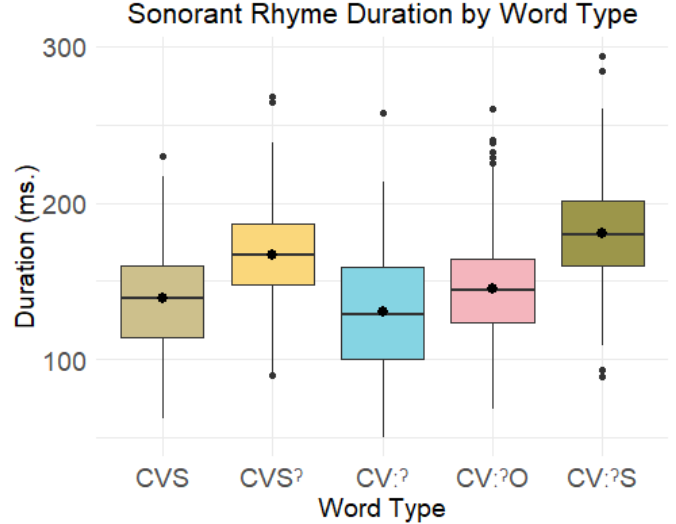
Figure 12. Sonorant rhyme duration in milliseconds by word type. CVS ˀ and CV ːˀ S words have the longest sonorant rhyme durations, which do not differ significantly. CVS, CV ːˀ , and CV ːˀ O words have shorter sonorant rhymes which do not differ significantly in duration. Black dots indicate the mean sonorant rhyme duration per word type.